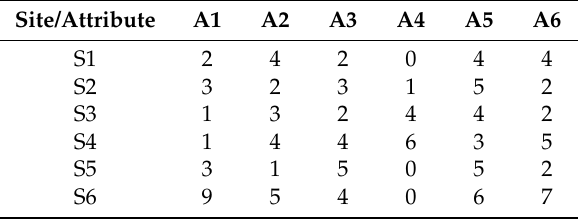
Table 12. Attribute access matrix of sites (AAMS).